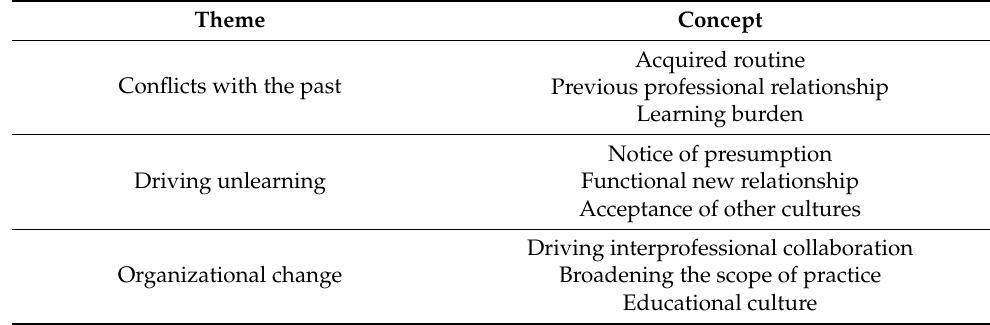
Table 3. The themes and concepts emerging from the processes of change for the